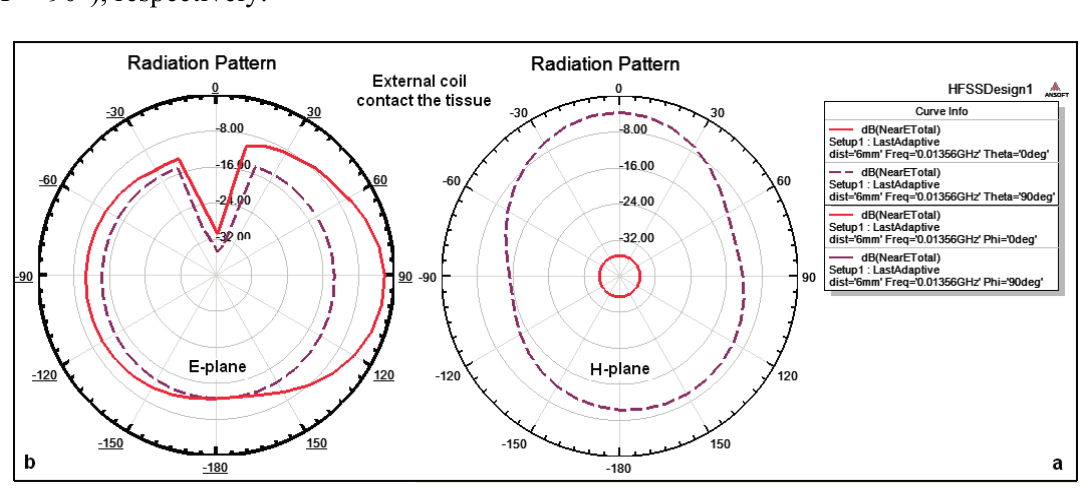
Figure 9. Simulated patterns for total near field surrounding external coil when it contacts the tissue: ( a ) On the azimuthal plane ( θ = 0°, θ = 90°); ( b ) on the elevation plane ( Φ = 0°, Φ = 90°), respectively.